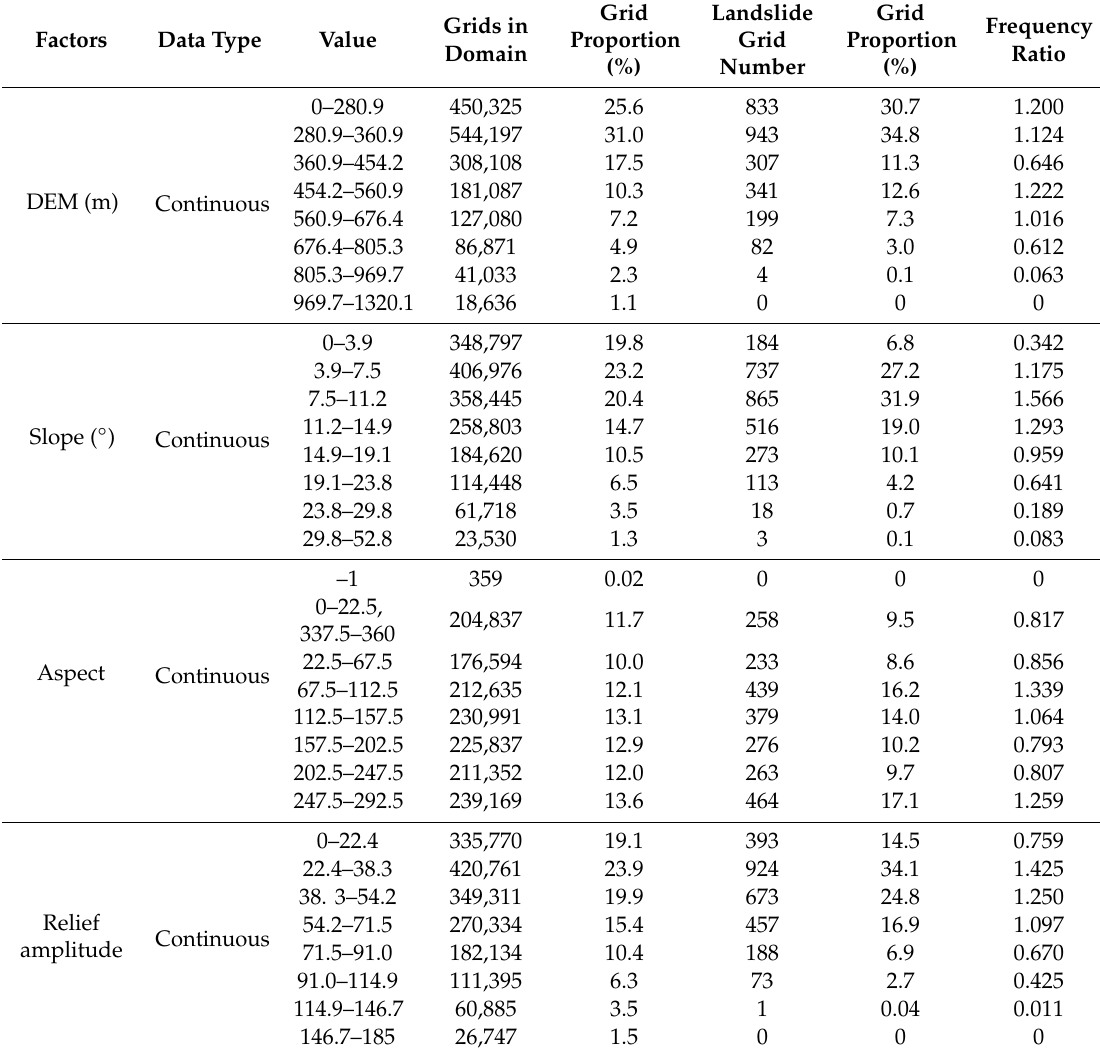
Table 1. Frequency ratios of landslide-related predisposing